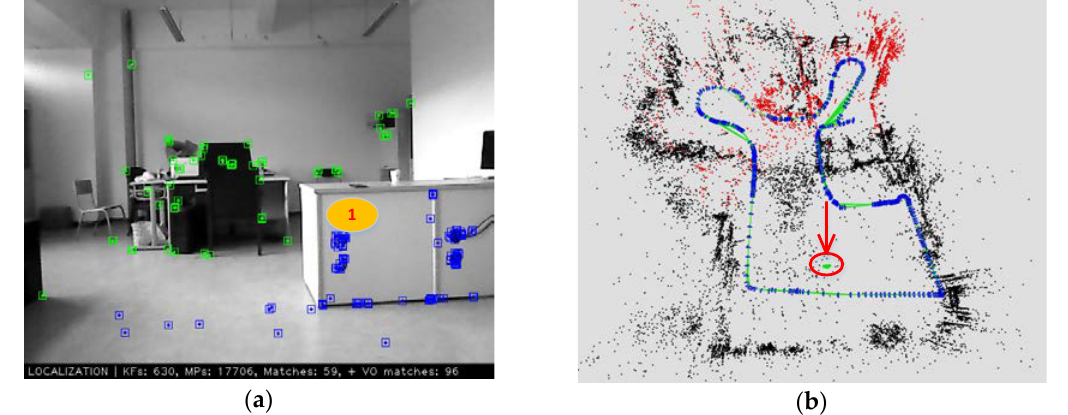
Figure 10. System global tracking status after relocation. ( a ) Current frame image after the complete robot moving; ( b ) real-time status of map and tracking.